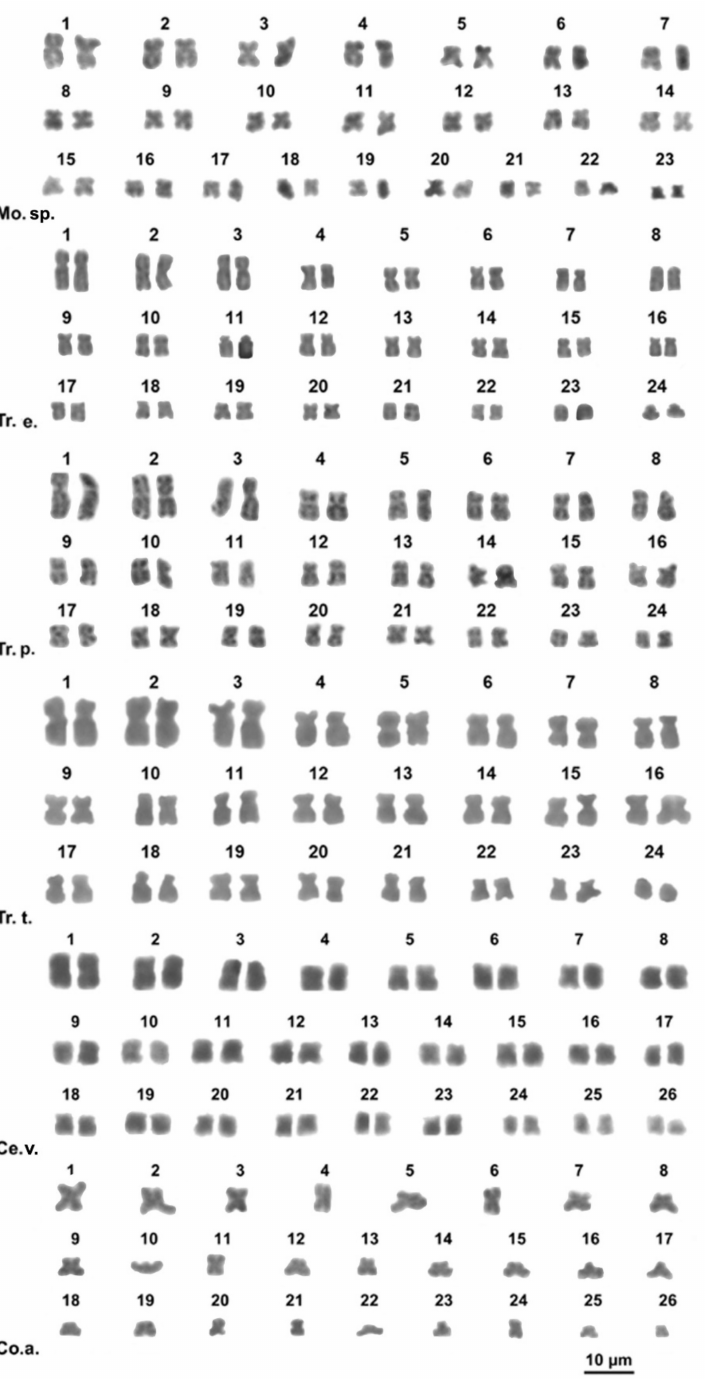
Figure 1. Giemsa stained karyotypes of Monacha sp. (Mo.sp.), Trochoidea elegans (Tr.e.), T. pyramidata (Tr.p.), T. trochoides (Tr.t.), Cernuella virgata (Ce.v), Cochlicella acuta